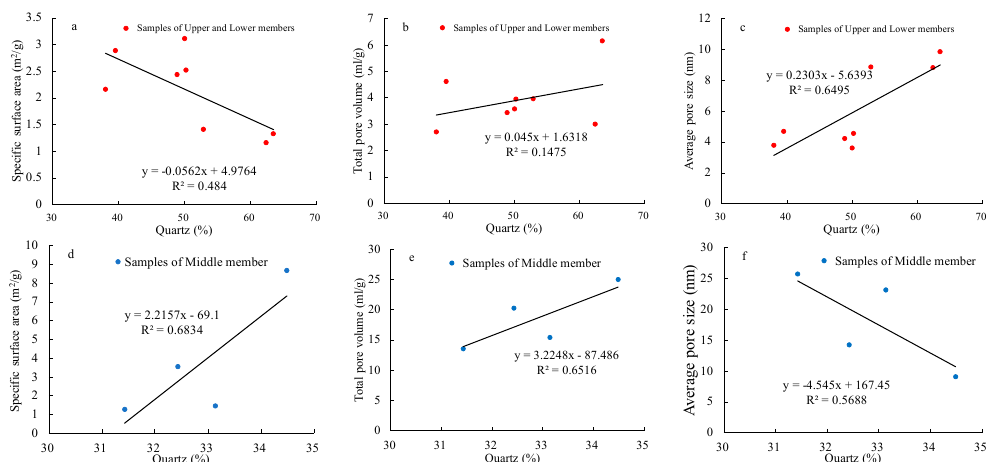
Figure 7. The relationship between pore structure parameters and quartz content. ( a ) Specific surface area vs. quartz content for Upper/Lower Bakken samples; ( b ) Total pore volume vs. quartz content for Upper/Lower Bakken samples; ( c ) Average pore size vs. quartz content for Upper/Lower Bakken samples; ( d ) Specific surface area vs. quartz content for Middle Bakken samples; ( e ) Total pore volume vs. quartz content for Middle Bakken samples; ( f ) Average pore size vs. quartz content for Middle Bakken samples.